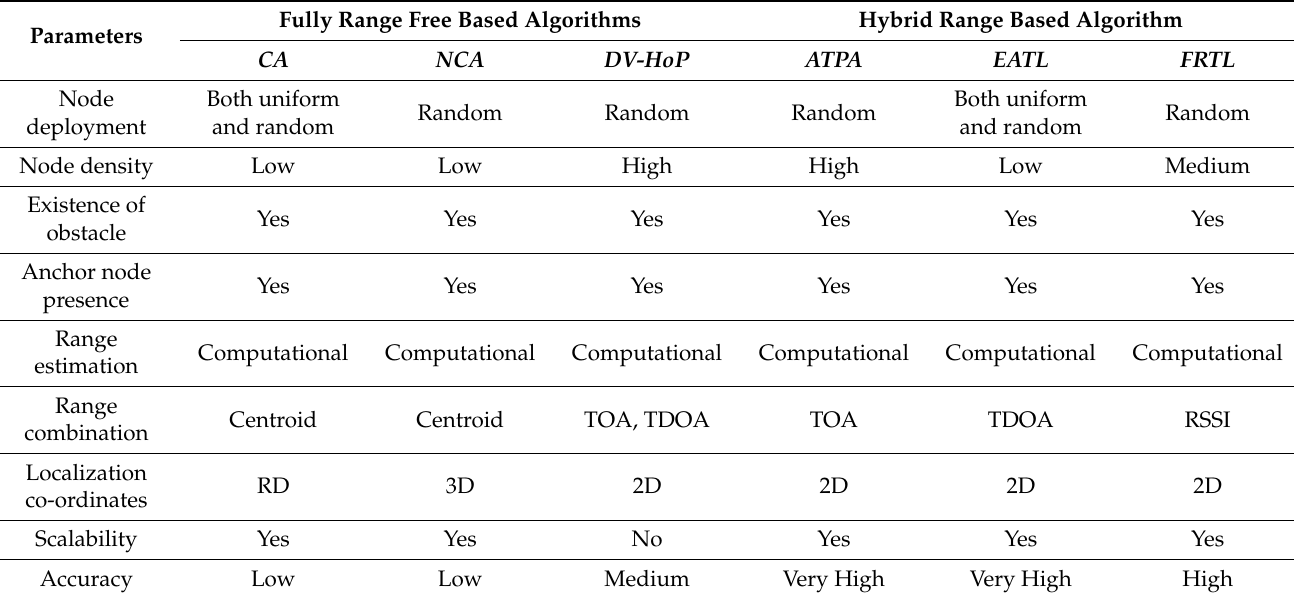
Table 2. These exploit geometry to improve hybrid AOA/TDOA-based localization (EATL). Fusion of RSSI and TDOA measurements from the wireless sensor network provides robust and accurate indoor localization (FRTL). Hybrid range-based algorithms perform better than fully range-based algorithms. Table 2 shows that hybrid range-based algorithms perform better in range combinations using TOA, TDOA, and RSSI. Scalability and accu- racy of the fully range-based algorithms are comparatively lower than those of hybrid range-based algorithms. Table 2. Localization algorithms (range free vs. hybrid range-based)